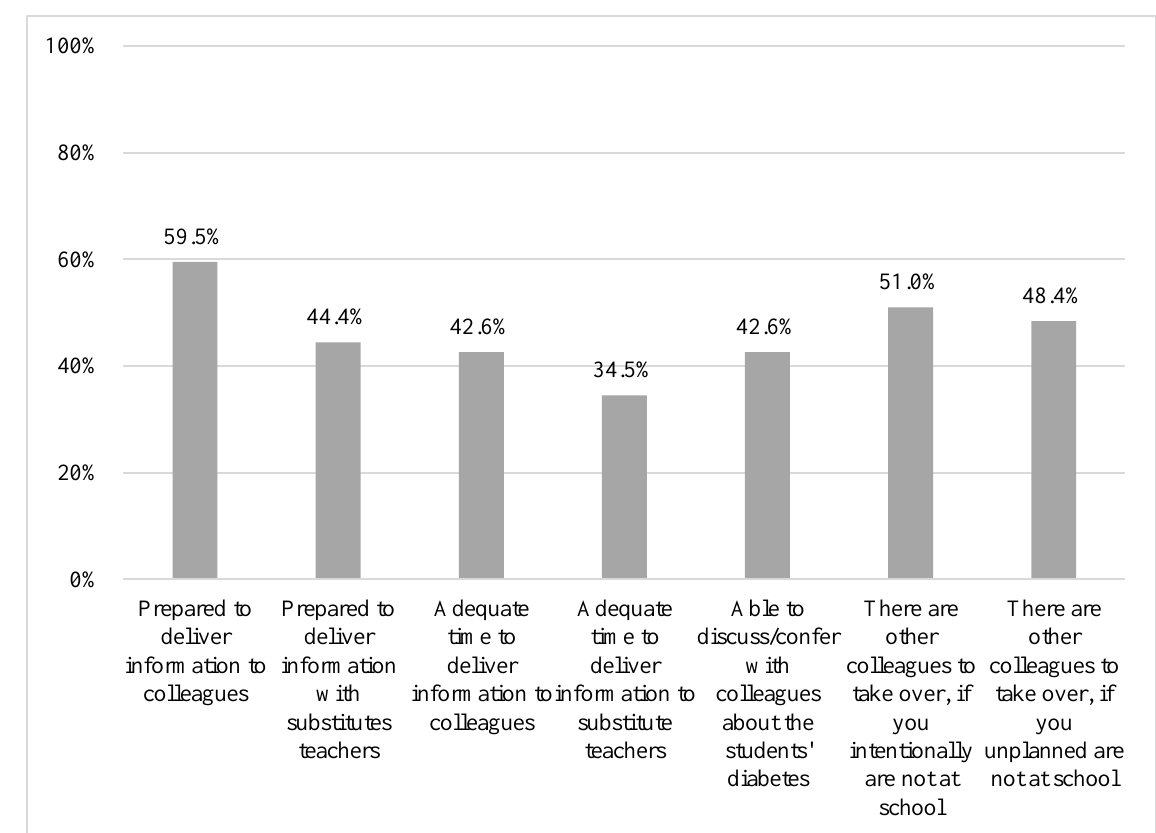
Figure 6. Participants' reports on experiences with colleagues.